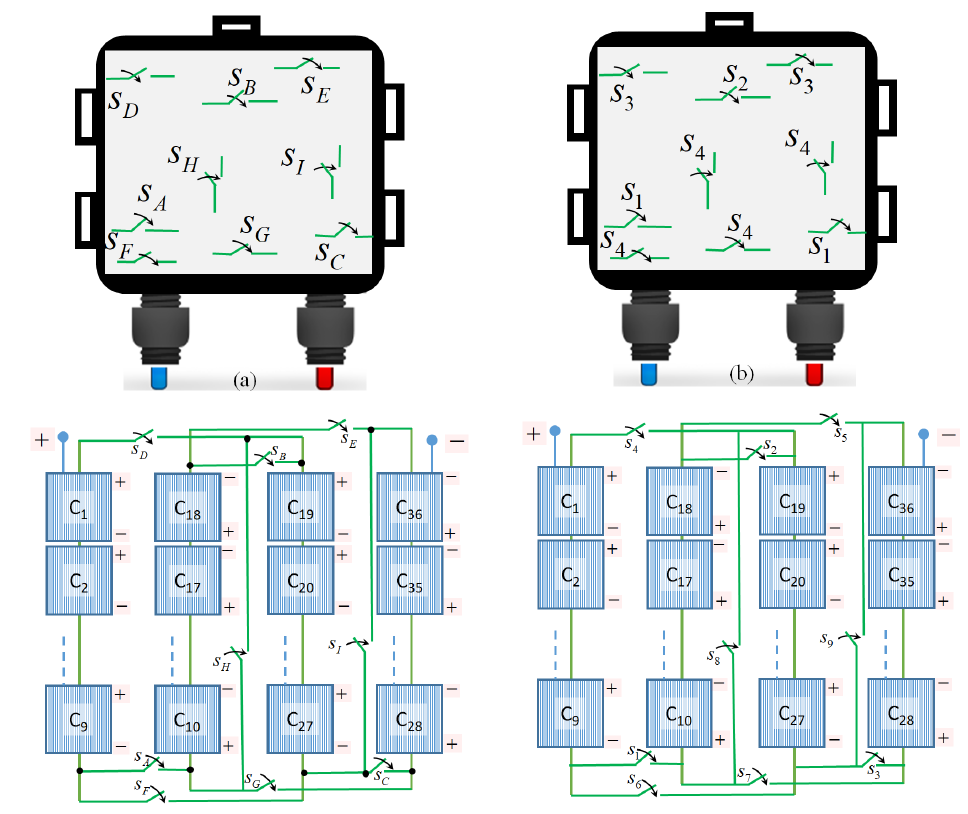
Figure 3. Junction box and the corresponding actual connections of the proposed switches ( a ) by implementing nine switches (labeled S A , S B , ... S I ) and ( b ) by replacing them by only four switches to maintain the same